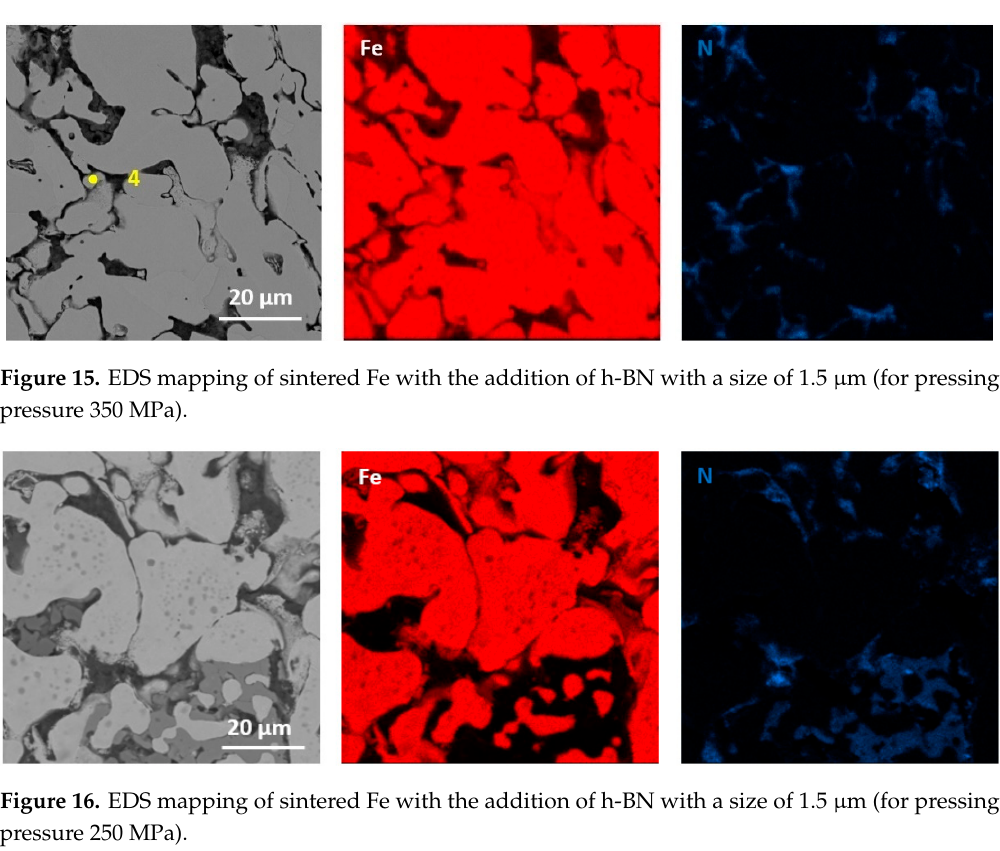
Table 5. EDS point analysis of a sintered Fe sample (for pressing pressure 350 MPa) containing 2.5% WS 2 with a grain size of 0.6 µ